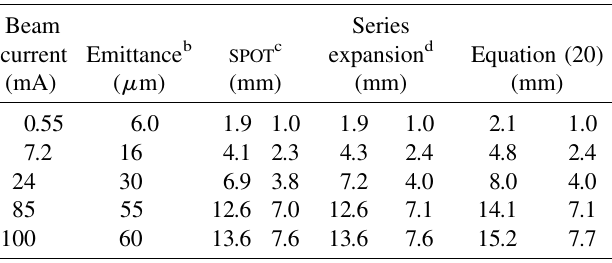
TABLE III. Maximum and minimum 2RMS envelope radii